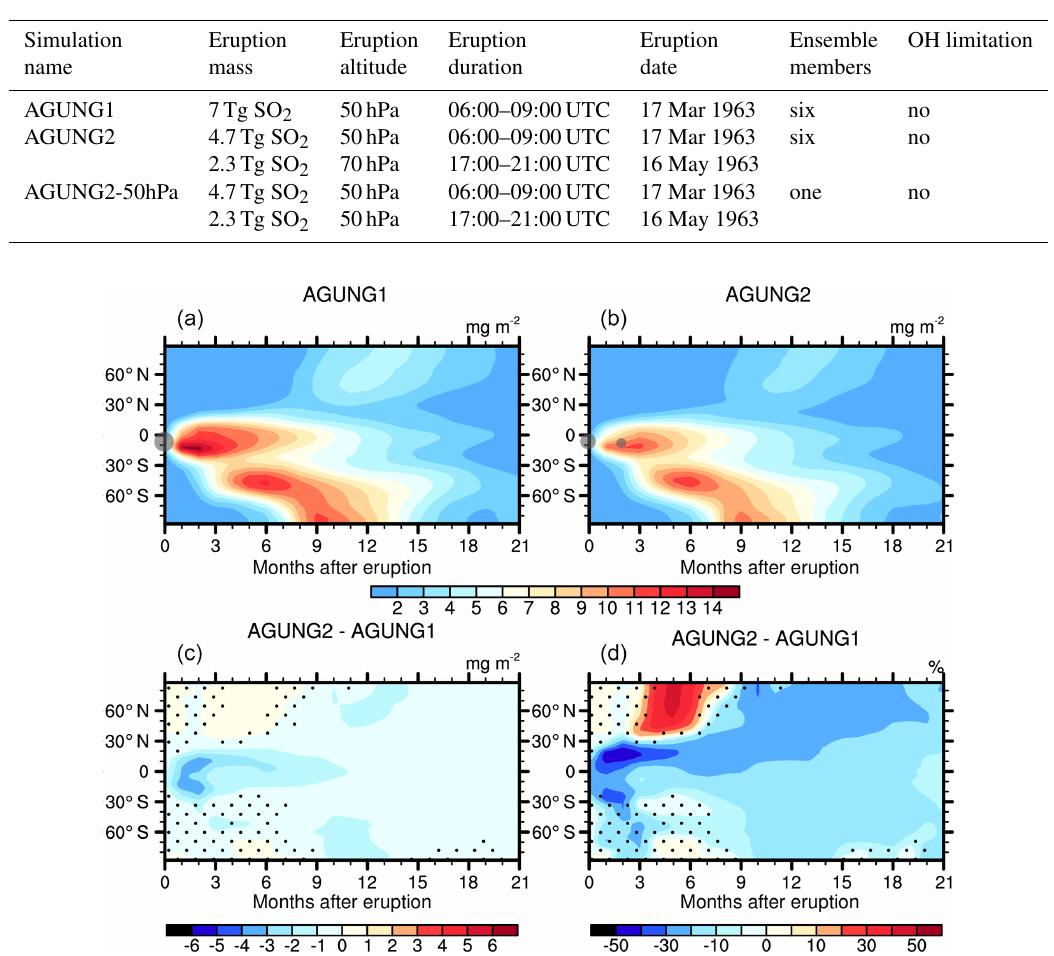
Figure 1. Ensemble mean of sulfate burden of experiments AGUNG1 (a) and AGUNG2 (b) . Absolute (c) and relative differences (d) of the two ensembles. The x axis gives the months after the first eruption in March 1963. Stippling indicates non-significant differences at the 99% level, following a Student’s t test. The gray dots mark the location and size of the volcanic